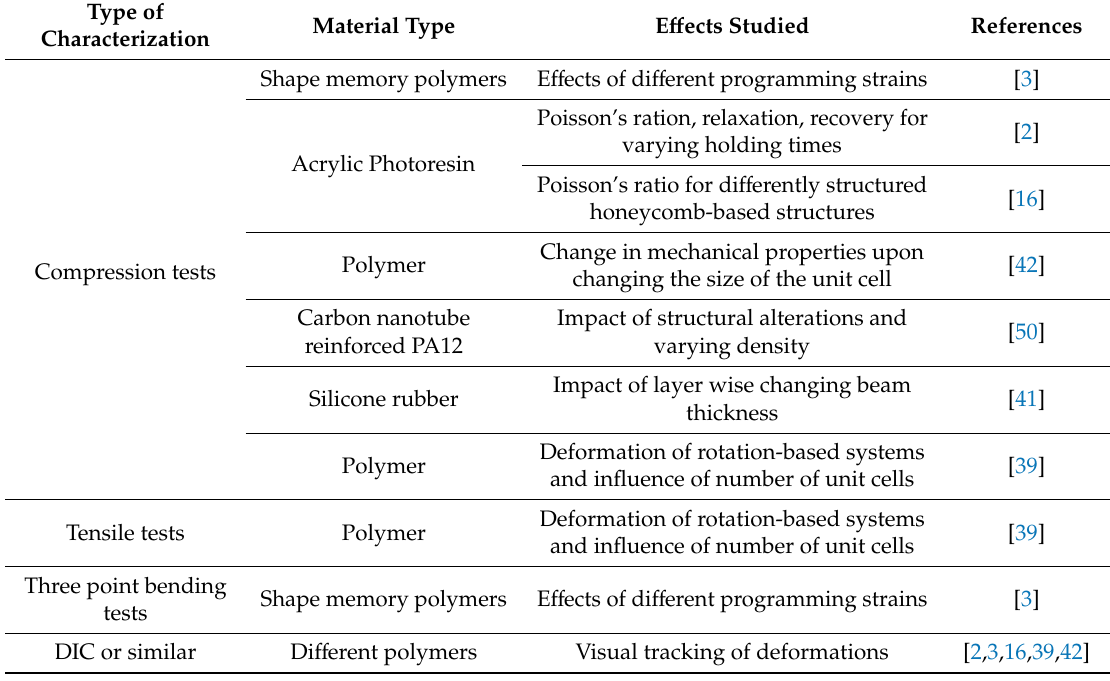
Table 1. Overview of di ff erent characterization methods for mechanical